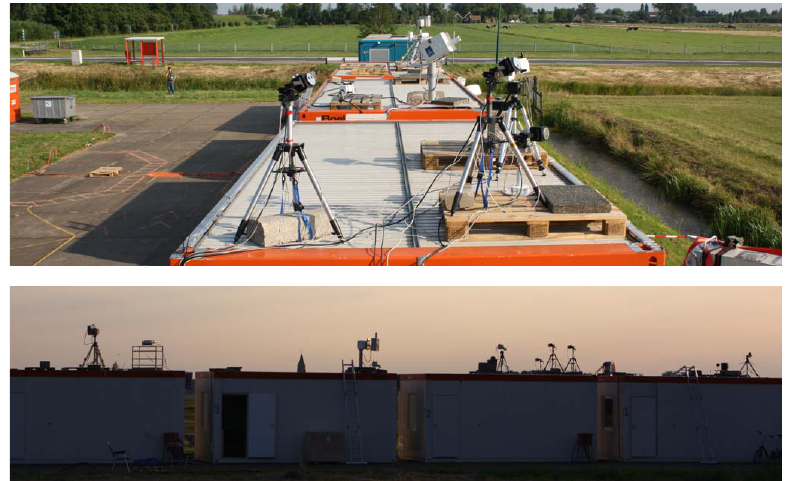
Fig. 3. Some of the roof-top instruments deployed at the campaign site, in views looking to the south (upper) and to the west (lower). Some other instruments were on the ground to the west of these containers; four other instruments were on the tower 370 m to the right of the lower picture; and a further three instruments were at the wind profiler site 160 m to the right of the upper picture.